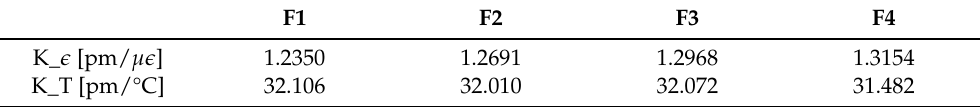
Table 1. Sensitivity of each fiber.